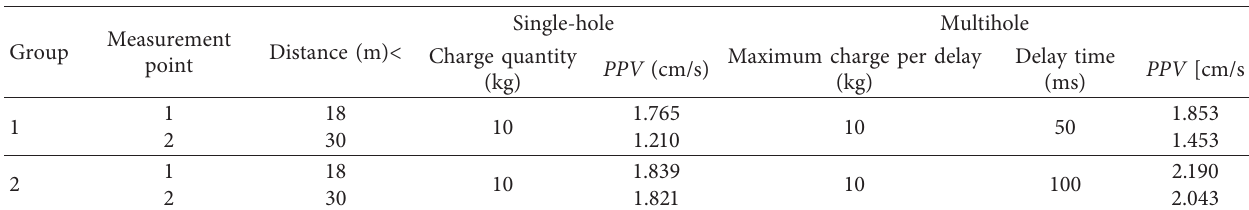
Figure 16: The variation of ß with different delay times. Table 5: Field tests data of blasting vibration